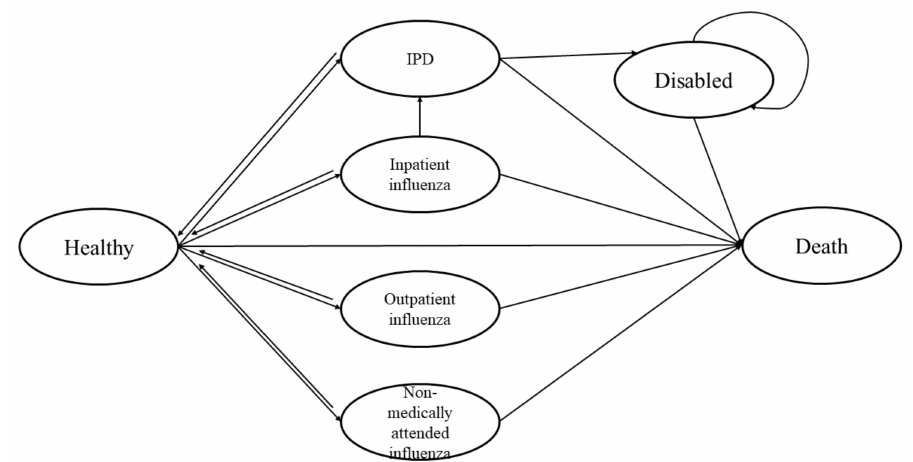
Figure 1. The structure of the Markov model. IPD, invasive pneumococcal